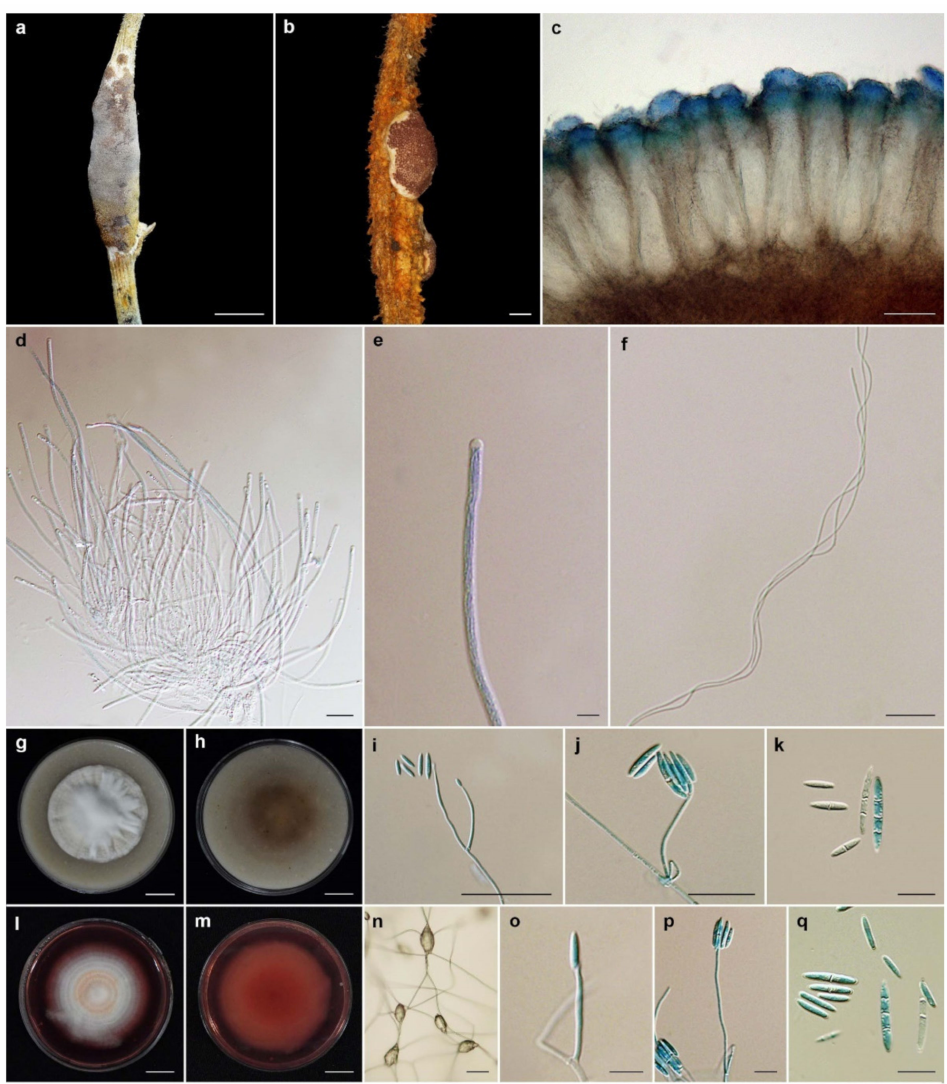
Figure 5. Ascopolyporus khaoyaiensis . ( a , b ) Stromata on living stem of dicotyledonous plants ( a BBH30157, b BBH30154); ( c ) perithecia; ( d ) asci; ( e ) asci-caps; ( f ) ascospores; ( g ) colony obverse on OA; ( h ) colony reverse on OA; ( i , j ) phialide apex with conidial head on OA; ( k ) conidia on OA; ( l ) colony obverse on PDA; ( m ) colony reverse on PDA; ( n – p ) phialide apex with conidial head on PDA; ( q ) conidia on PDA. Scale bars: ( b , g , h , l , m ) = 10 mm; ( a ) = 5 mm; ( c ) = 100 µ m; ( i ) = 50 µ m; ( d , f ) = 20 µ m; ( g , j , k , n , o , p , q ) = 10 µ m; ( e ) = 5 µ